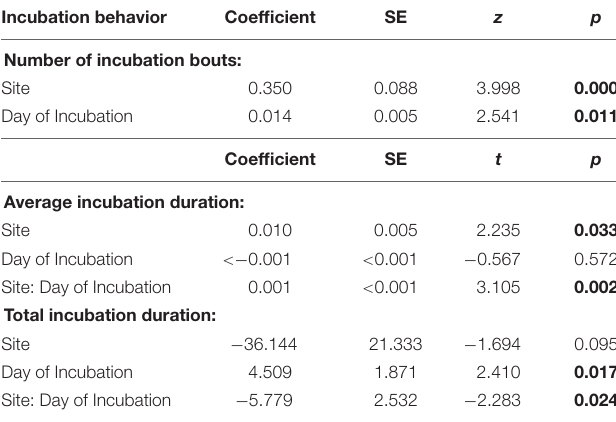
TABLE 1 | Results from generalized linear mixed model (number of incubation bouts) and linear mixed models (average and total incubation duration) analyzing differences in incubation behavior between urban and rural house wren